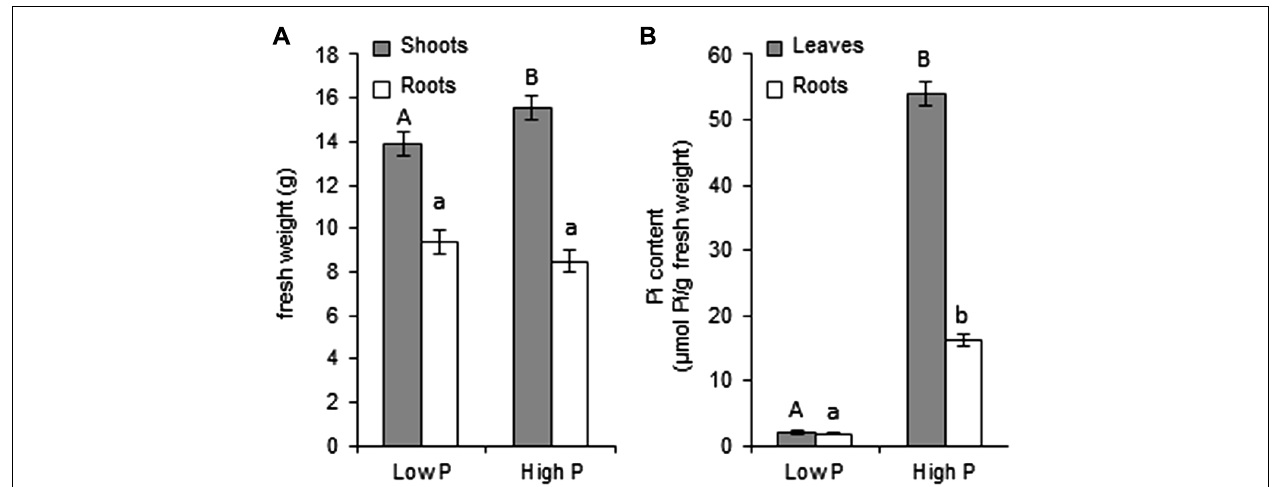
P = 0.045; roots: lower case, P = 0.223). (B) Free Pi content was measured in extracts from leaves (gray bars) and roots (white bars); n = 3 plants per condition. Different letters indicate statistically significant differences according to the Student’s t -test (leaves: upper case, P < 0.001; roots: lower case, P <